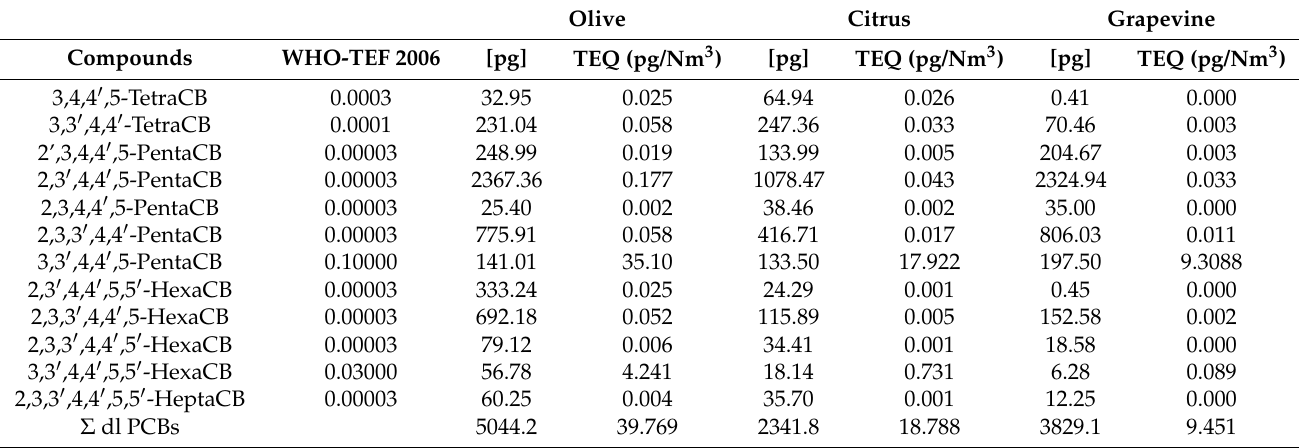
Table 7. PCB amounts in pg and concentrations in Toxicity Equivalent (TEQ ng/Nm 3 ) of Olive, Citrus and Grapevine samples.